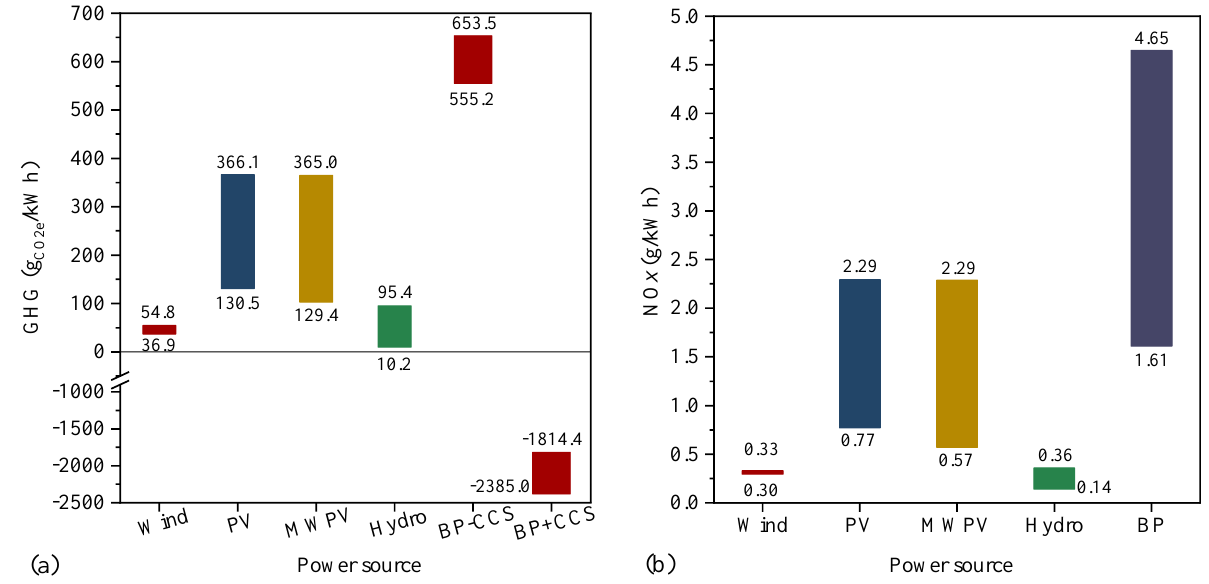
Figure 3. Life cycle of GHG and NO x emissions with different power sources. ( a ) GHG; ( b ) NO x .